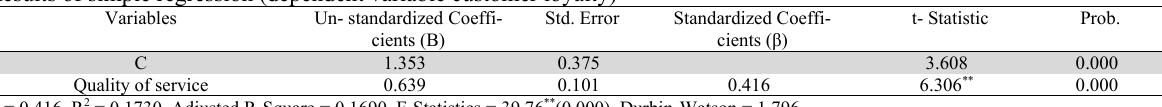
Results of simple regression (dependent variable customer loyalty)